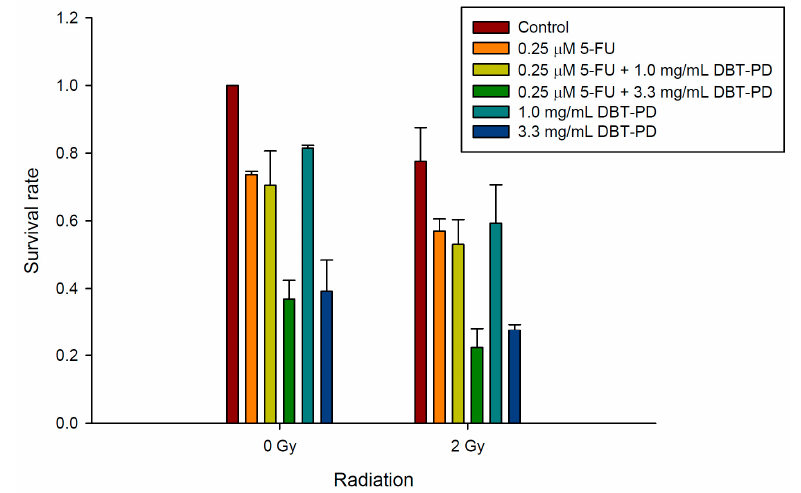
Figure 5. Effect of DBT-PD on survival of CT26 cells subjected to CCRT. CT26 cancer cells were treated with 0.25 µM 5-FU and 1.0 or 3.3 mg/mL DBT-PD for 24 h before 2-Gy irradiation. A colony formation assay was performed to estimate survival post CCRT. Data from 3 experiments are presented as mean ± standard deviation.